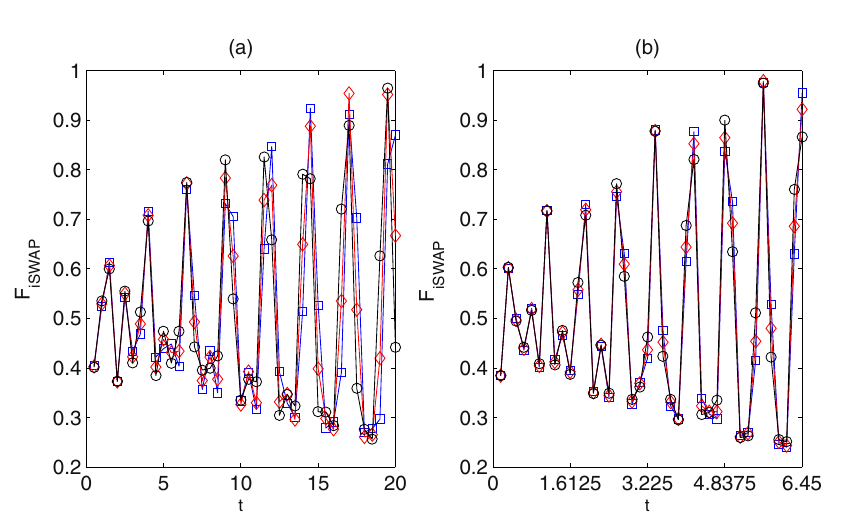
Figure 9. The average fidelity of the iSWAP gate vias g and evolution time. ∆ = g 9 Ω = g 2 . ( a ) The diamonds refer to ≈ . g 5 275 , the squares and the circle refer, respectively, to a variation of − 0.025 and + 0.025 of g . ( b ) The diamonds refer to ≈ . g 18 4 , the squares and the circle refer, respectively, to a variation of − 0.05 and + 0.05 of g .